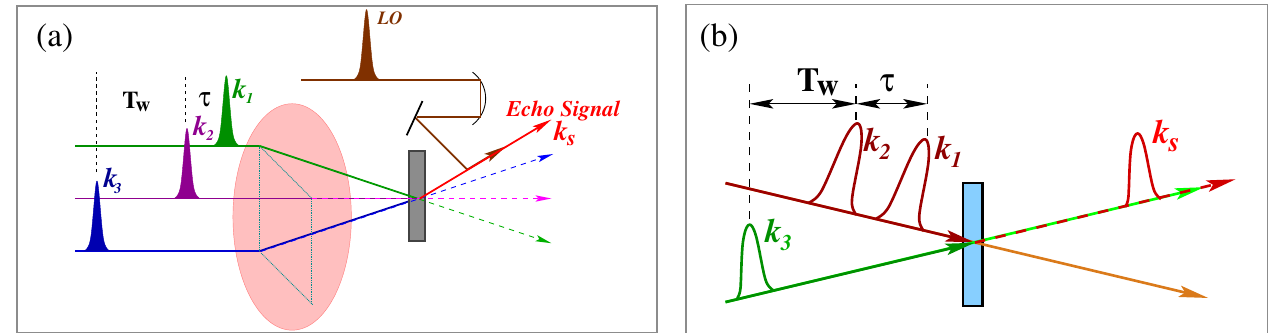
Figure 5. Schematic layouts of 2DIR experiments: ( a ) four-wave mixing method in box-cars geometry and ( b ) partly collinear method as like pump-probe